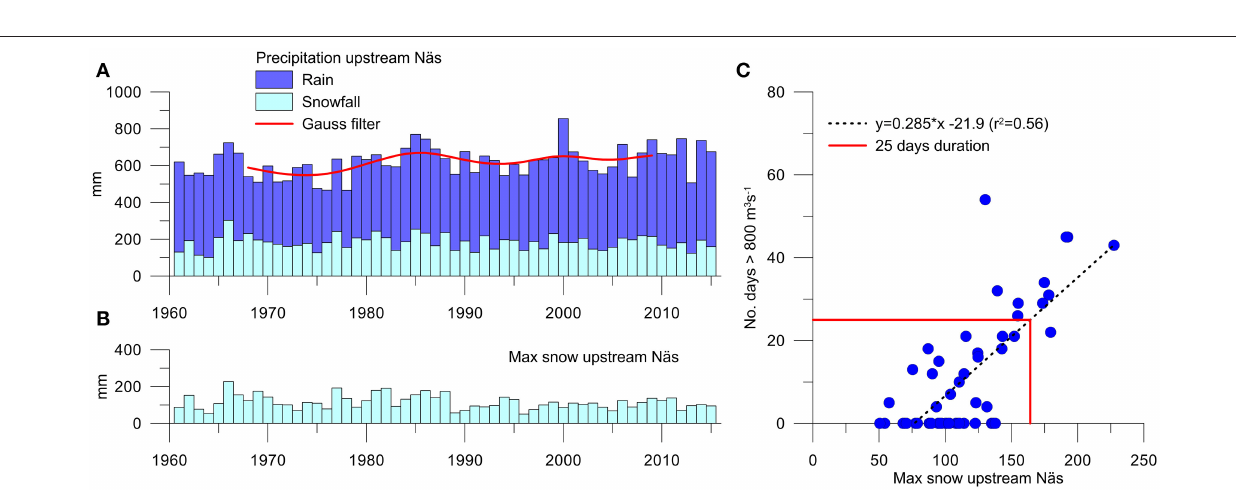
FIGURE 4 | Annual precipitation in Dalälven watershed upstream of Näs with fractions falling as rain and snow ( A, upper left ), annual maximum snow storage upstream of Näs ( B, lower left ), correlation between flood duration (continuous number of days of unregulated flow exceeding 800 m 3 s − 1 during the period between April and June) and annual maximum snow storage upstream Näs ( C, right